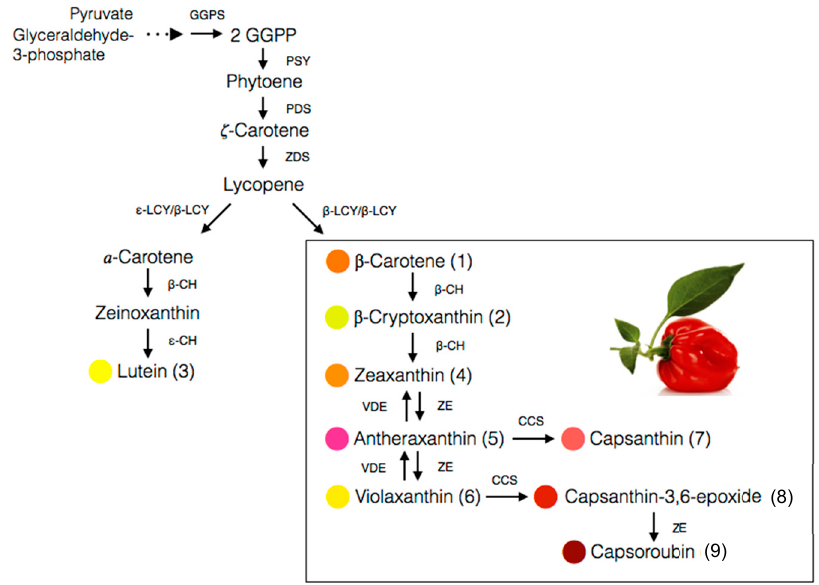
Figure 4. Biosynthetic pathways of main carotenoids in the red-fruited Capsicum species. GGPP, geranylgeranyl pyrophosphate; GGPS, geranylgeranyl pyrophosphate synthase; PSY, phytoene synthase; PDS, phytoene desaturase; ZDS, ζ -carotene desaturase; β -LCY, lycopene- β -cyclase; ε -LCY,